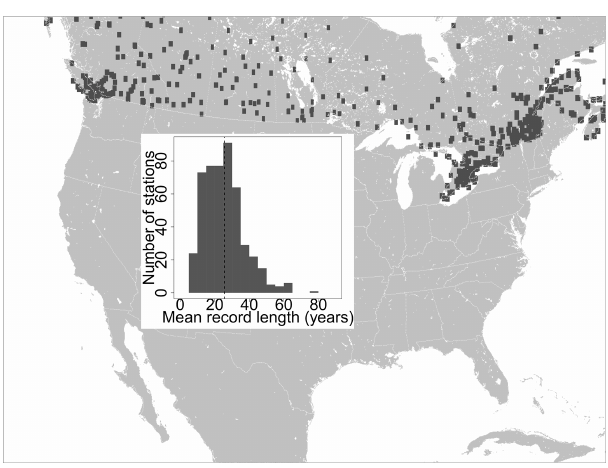
Figure 1. Map showing the NCAR HRCONUS WRF land mask and locations (rectangles) of the 488 IDF curve TBRG stations in Canada. The inset plot shows a histogram of mean record length (all IDF curve durations) at the stations; the median (vertical dashed line) is 25